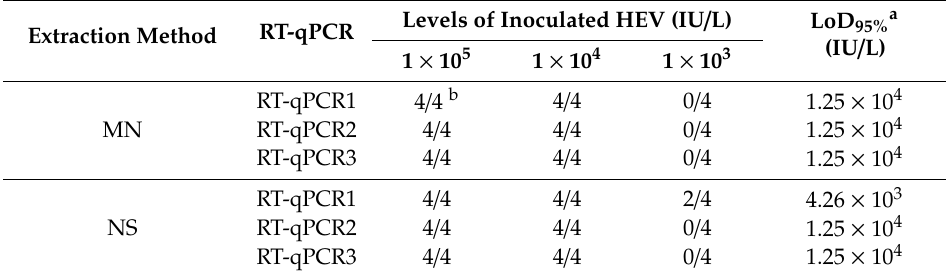
Table 2. Limit of detection of HEV in bottled water according to ISO 15216-1:2017 virus concentration procedure and comparing two extraction kits and three RT-qPCRs assays. Extraction Method